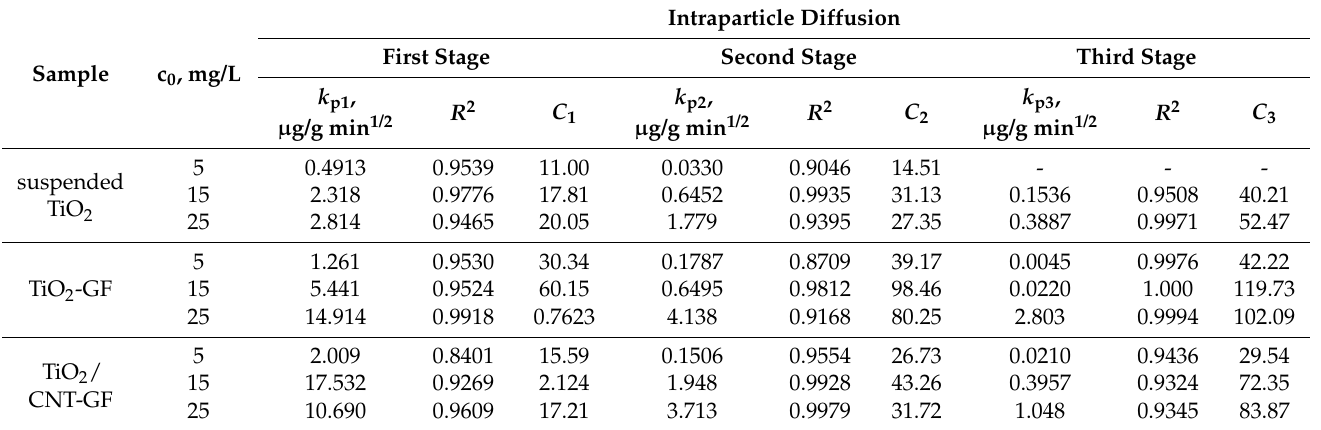
Table 5. Intraparticle diffusion model for CRZ.